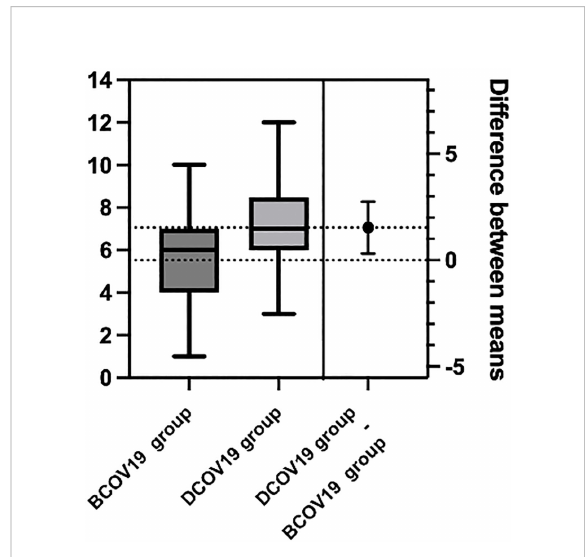
FIGURE 1 Comparison of median delayed diagnosis time in BCOV19 and DCOV19